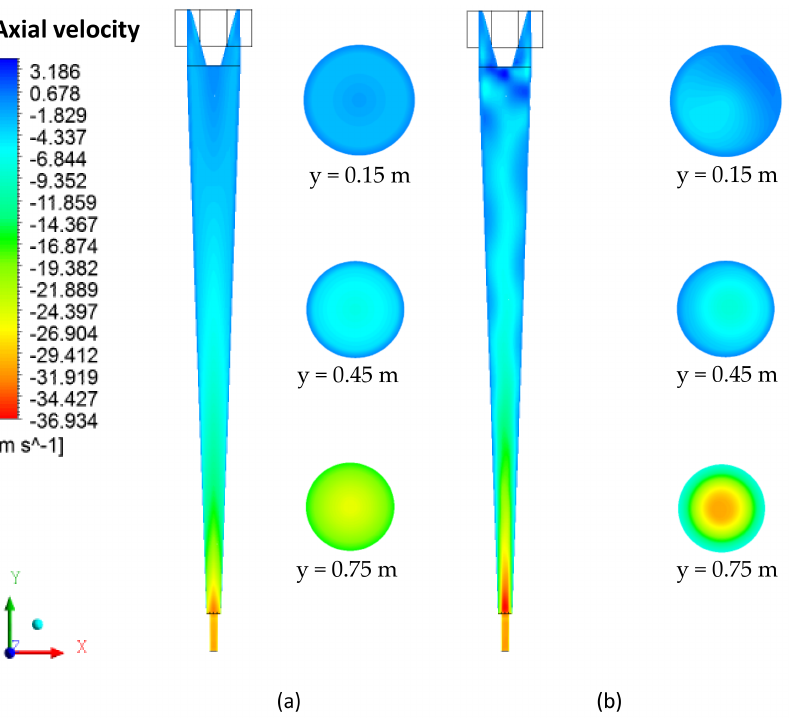
Figure 9. Water axial velocity field in the yz plane. ( a ) Conventional hydrocyclone and ( b ) filtering